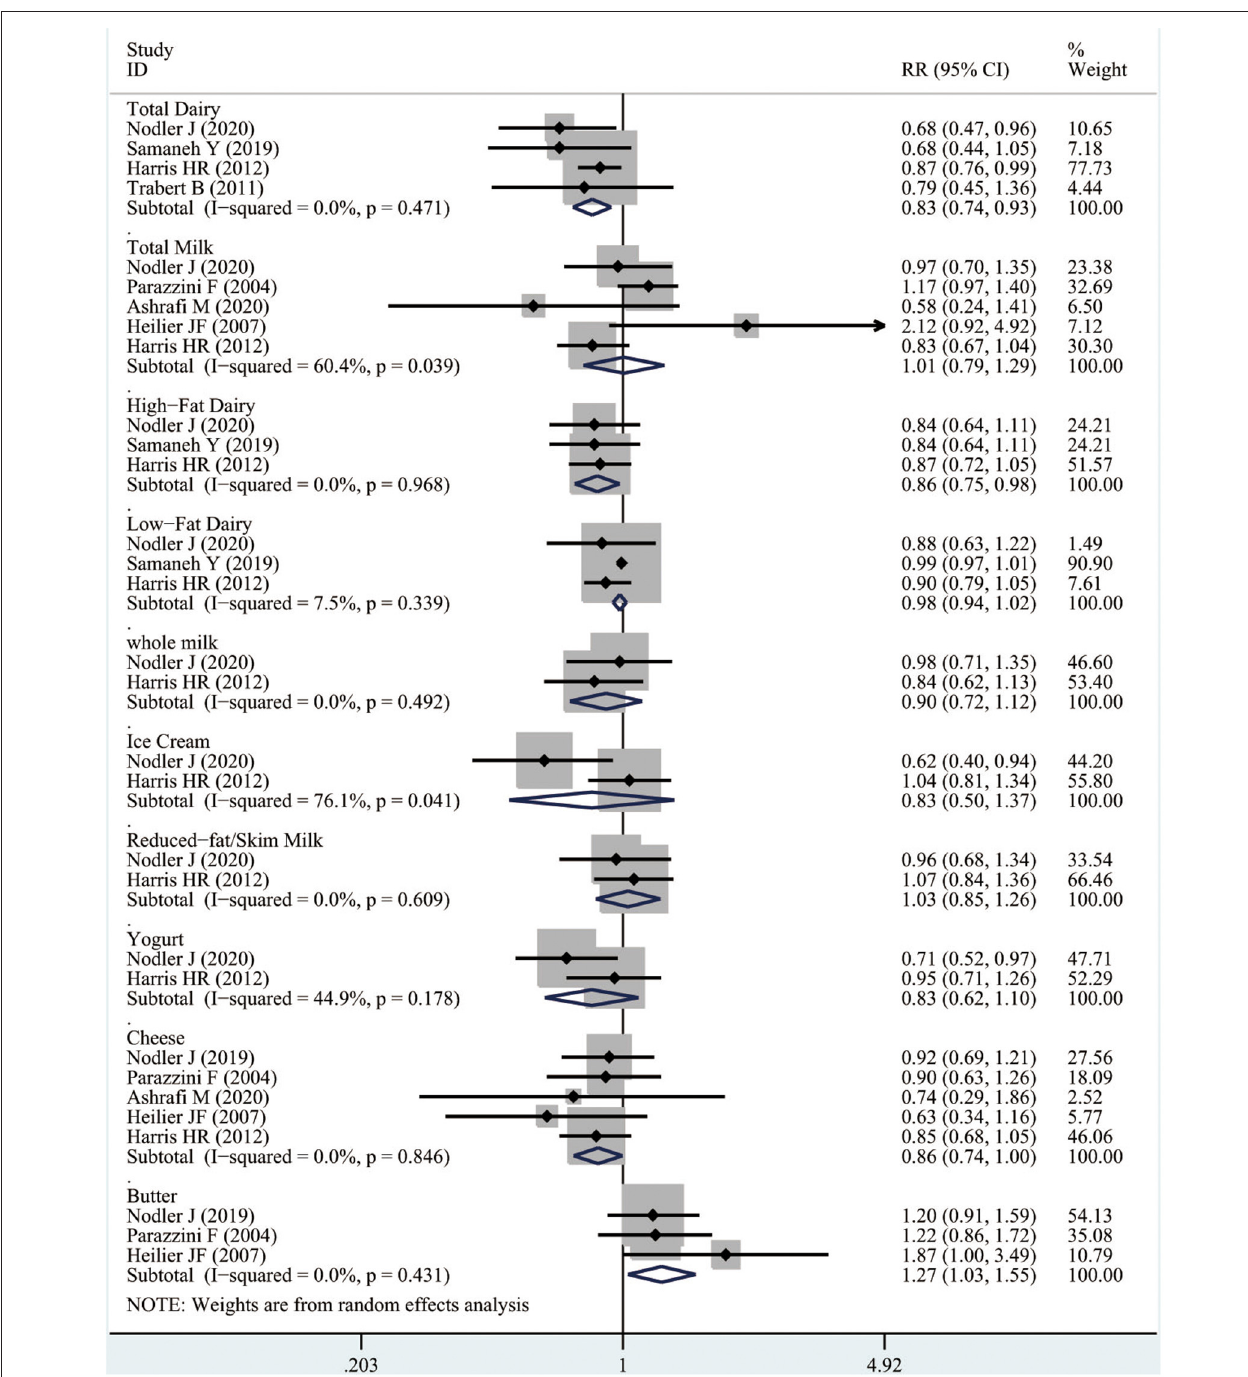
FIGURE 2 | Forest plots of dairy products intake and the risk of endometriosis.